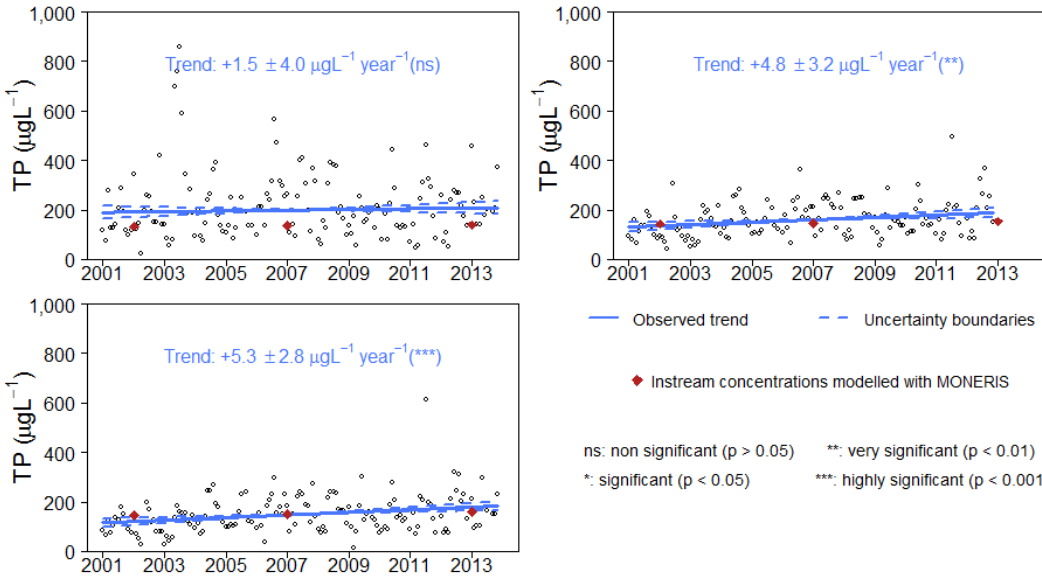
Figure 3. Observed trends of TP concentration compared to modelled TP concentrations for the years 2002, 2007 and 2013 in the three sub-catchments of the river Pram: ( a ) upstream; ( b ) midstream; and ( c ) downstream. Plotted values of TP concentrations correspond to flow-adjusted data. They were calculated by adding the residuals obtained from the concentration versus flow regression to the mean concentration for the period under study [25].